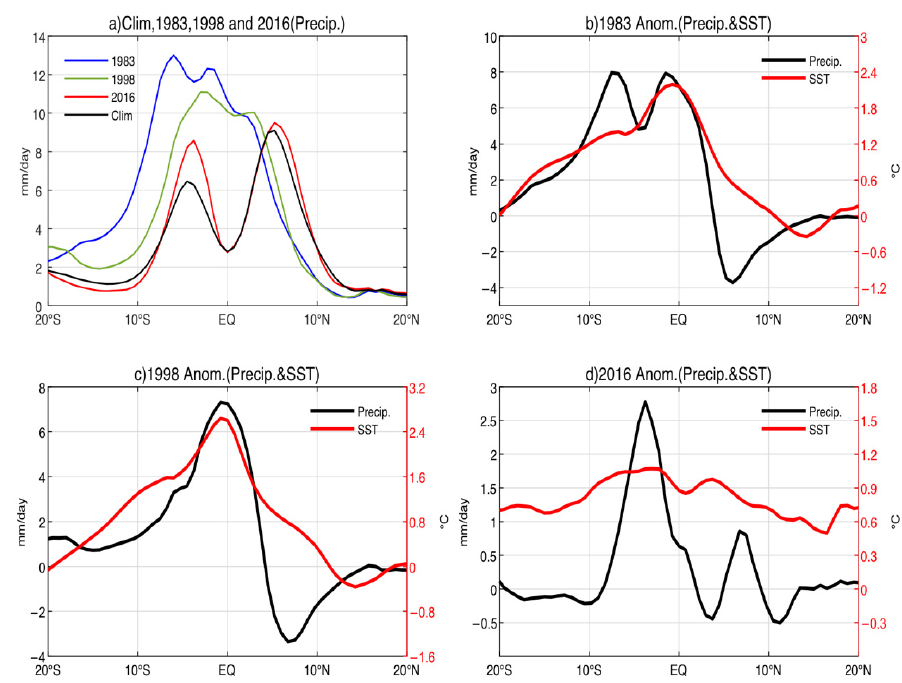
Figure 4. ( a ) Zonal-mean precipitation (mm/day) over the eastern Pacific (140 ◦ W–80 ◦ W) in March–April for climatology (black), 1983 (blue), 1998 (green) and 2016 (red). Anomalous zonal-mean precipitation (black; mm/day) and SST (red; ◦ C) between 140 ◦ W–80 ◦ W for three extreme El Niños in March–April: ( b ) 1983 ( c ) 1998, ( d ) 2016.